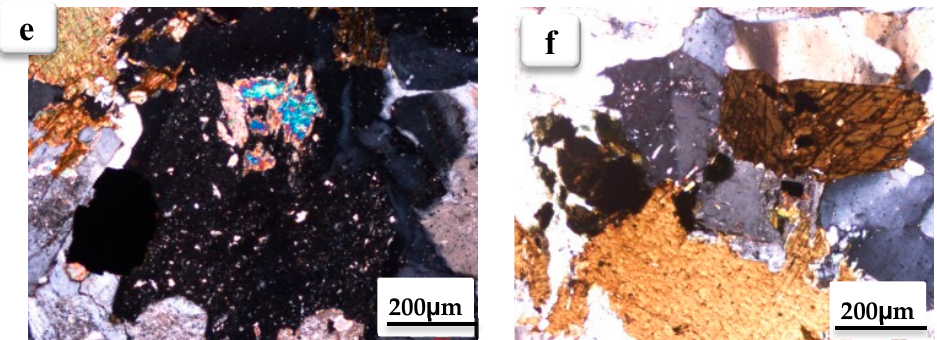
Figure 3. Photomicrographs for Aswan granite showing: ( a ) Plagioclase corroded by perthite, CN; ( b ) epidotization and muscovitization of plagioclase, CN; ( c ) muscovitization of plagioclase, CN; ( d ) anhedral flake of ferribiotite associating antiperthite, CN; ( e ) secondary muscovite after plagioclase (muscovitization), CN; ( f ) basal section of hornblende with two-sets cleavage associating plagioclase, CN.